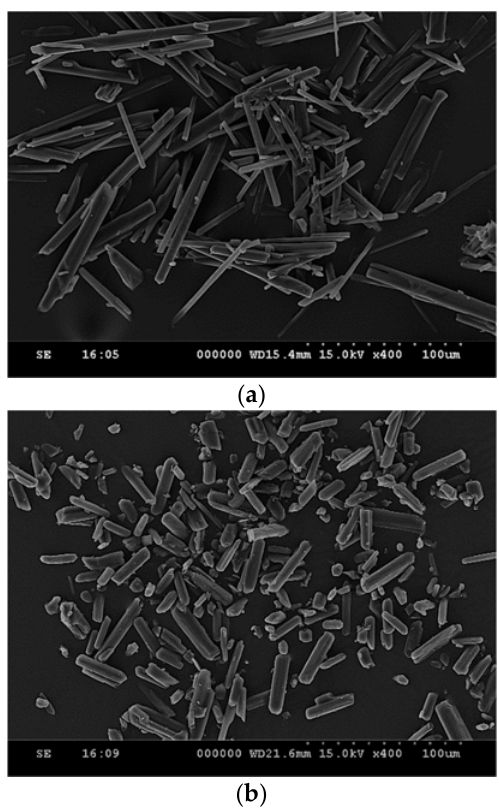
Figure 10. SEM images of N ′ -(propan-2-ylidene)-isonicotinohydrazide: ( a ) crystals obtained in Experiment B2 and ( b ) crystals obtained in Experiment 8.